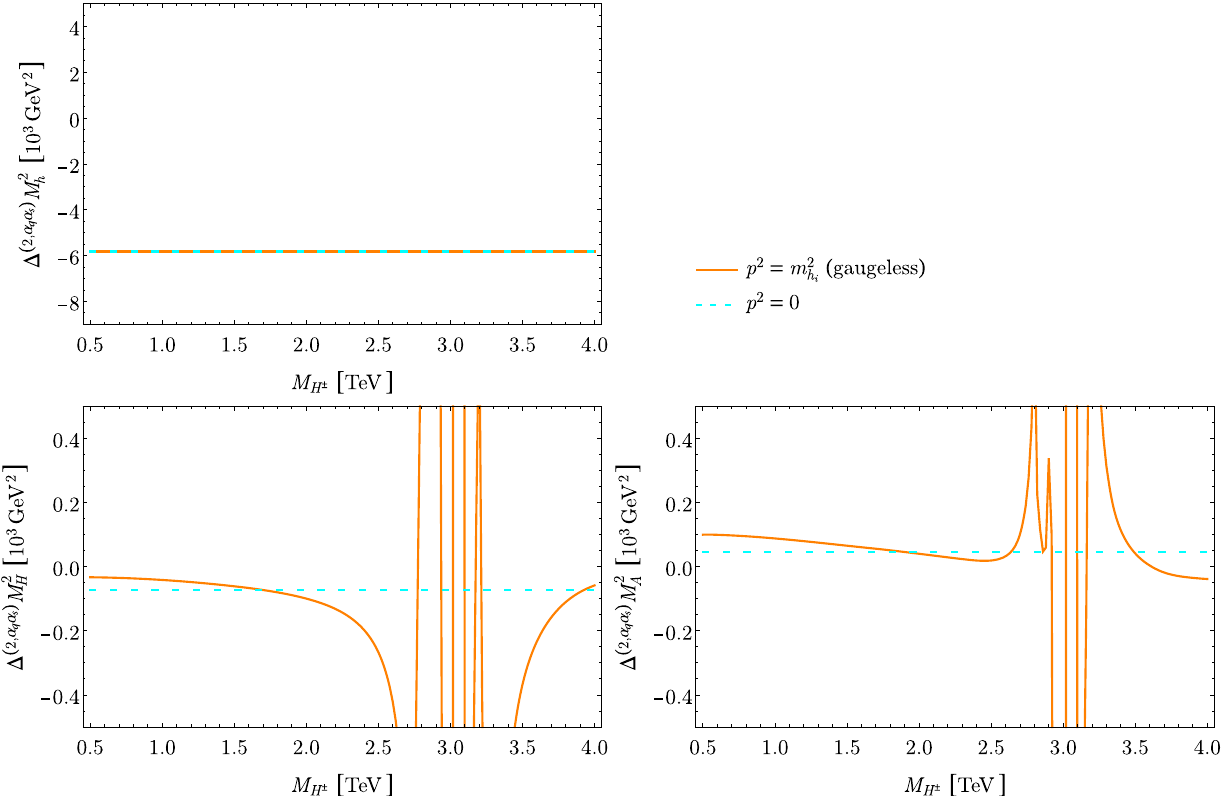
Fig. 2 Mass shifts at O (α q α s ) for the neutral Higgs states. The result in the gaugeless limit is shown in orange with momentum set to the (gaugeless) tree-level mass. The dashed cyan curve corresponds to the effective-potential